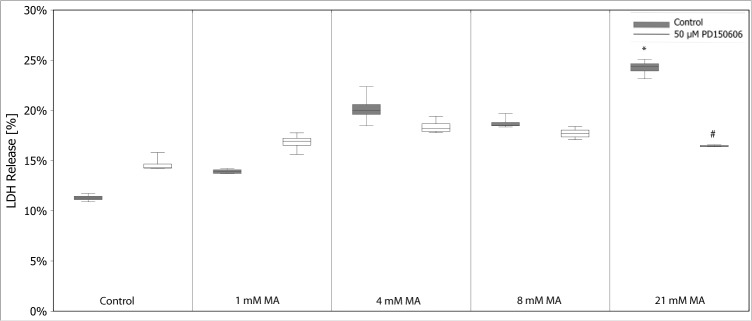
MA toxicity activates calpain pathways.MA treatment activated calcium-dependent calpain proteases as indicated by the reduction of MA-induced LDH release by the inhibitor PD 150606 (50 µM). Data are presented as percent of MA treated control cells of n = 5 independent experiments.